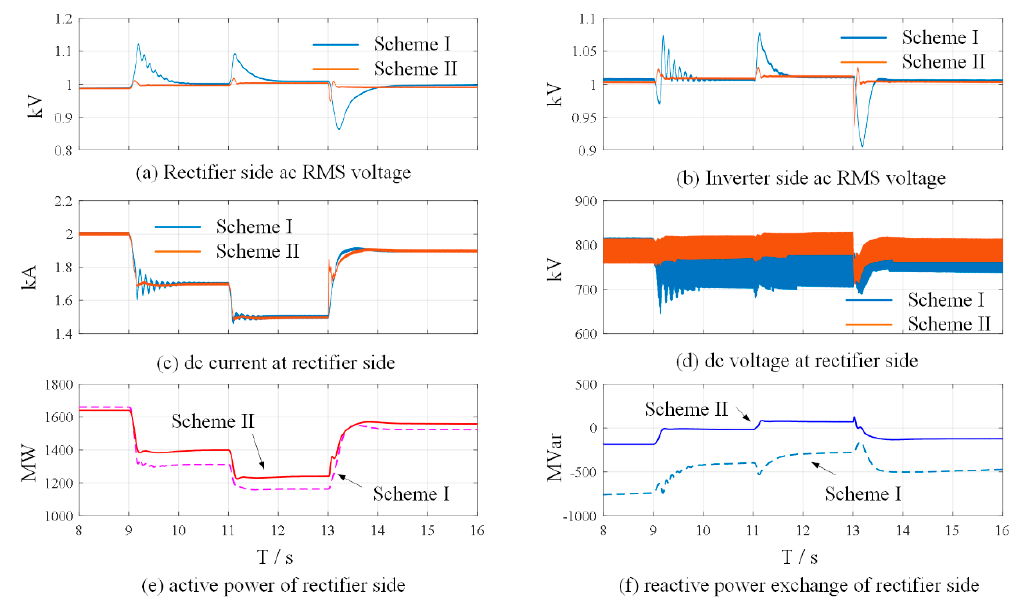
Figure 15. Hybrid HVdc simulation results for dc current reference changing.